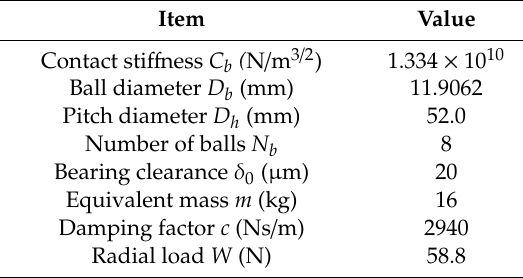
Table 6. Specifications of the ball bearing in [14].